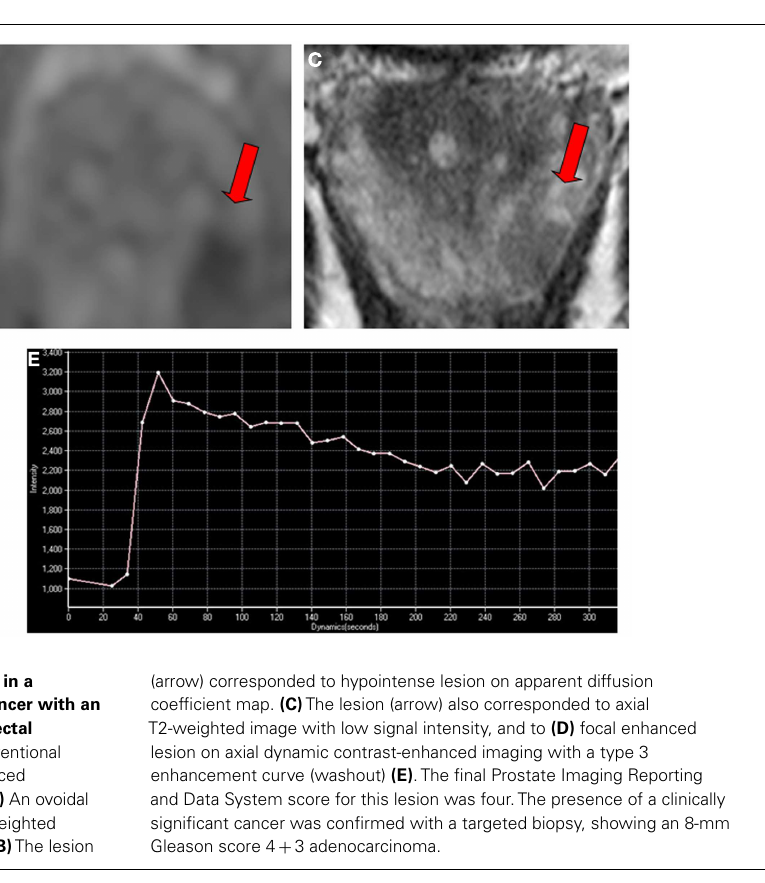
FIGURE 1 | Multi-parametric magnetic resonance imaging in a 65-year-old man referred for early detection of prostate cancer with an elevated serum PSA level (7ng/ml) and a normal digital rectal examination . Magnetic resonance imaging consisted of conventional T2-weighted, diffusion-weighted, and dynamic contrast-enhanced sequences performed on a 3T unit without endorectal coil. (A) An ovoidal hyperintense lesion (arrow) was observed on axial diffusion-weighted imaging at b -value 1000s/mm 2 in left apical peripheral zone. (B) The lesion